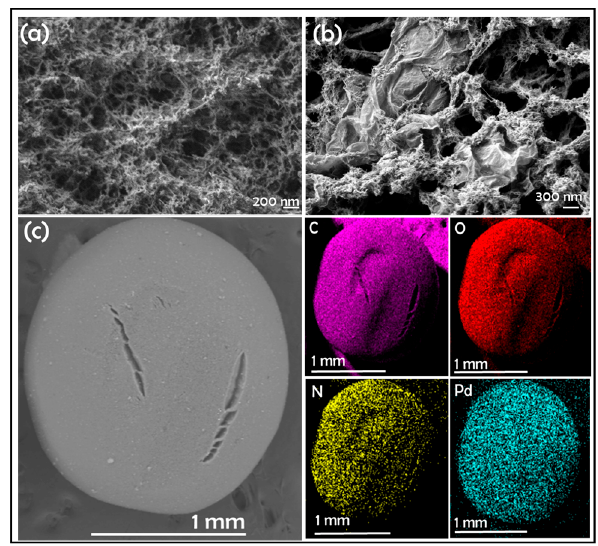
Figure 1. FESEM images of ( a ) Pd/CS, ( b ) Pd/CS-GO3, and ( c ) low resolution FESEM image and corresponding Energy-Dispersive X-Ray Spectroscopy (EDX) elemental analysis of elements for a bead of Pd/CS-GO2.